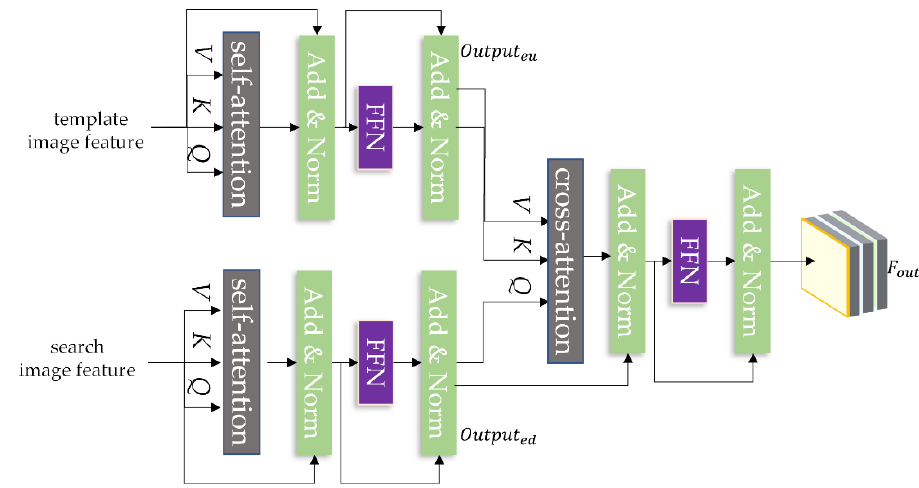
Figure 4. Principle diagram of transformer structure.